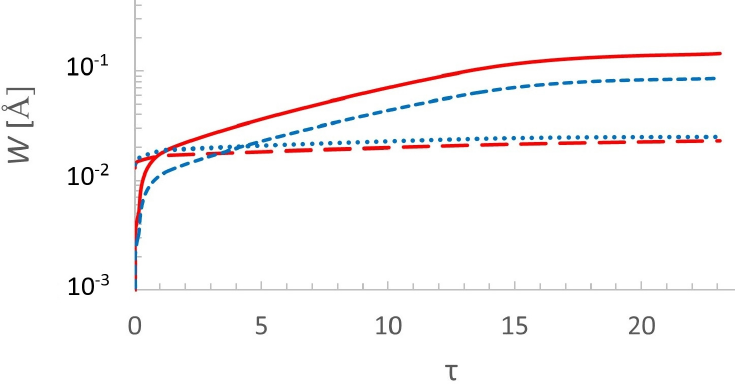
Figure 4. Same as in Figure 2 but for the atmosphere of a DO white dwarf. The atmosphere model from [37] with parameters T ef f = 60,000 K and log g =